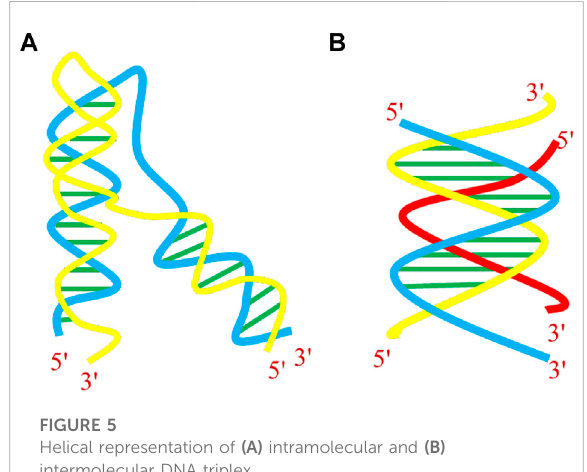
FIGURE 5 Helical representation of (A) intramolecular and (B) intermolecular DNA